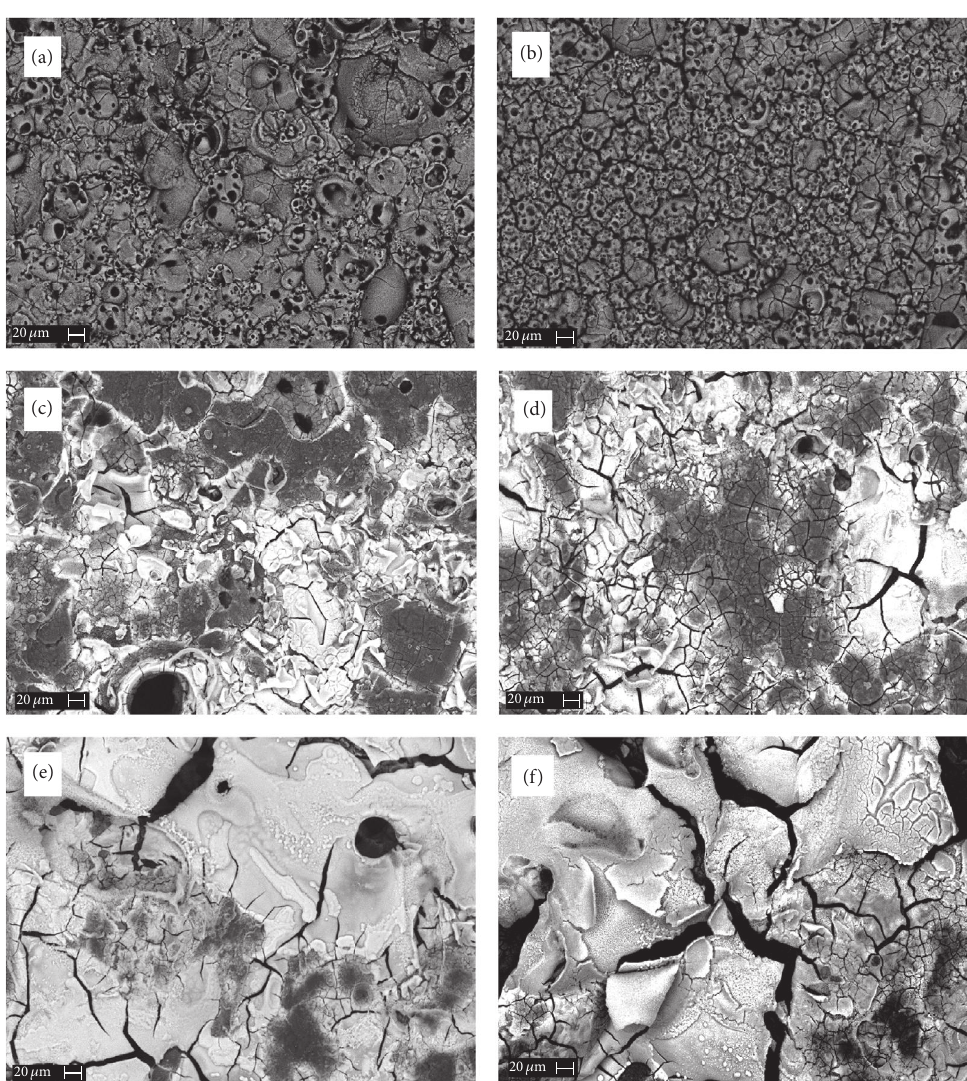
Figure 15: Scanning electron micrographs (backscattered electrons) of the surface of the samples before and after 7 days of immersion. In detail PEO treated before (a) and after (b) immersion, sealed at 30 ∘ C for 10min before (c) and after (d) immersion, and sealed at 50 ∘ C for 30 min before (e) and after (f)